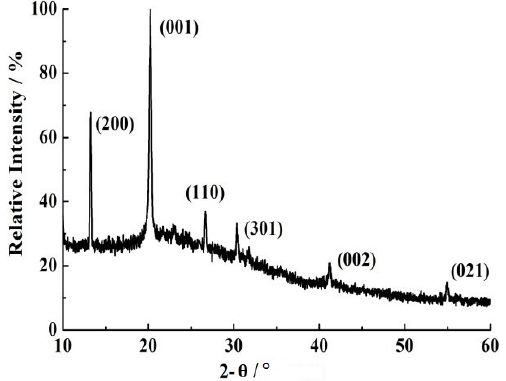
Figure 2. XRD pattern of as-grown vanadium oxide thin films by APCVD on fluorine-doped SnO 2 (FTO) glass substrates at 450 °C, using gas precursor ratio of 1:3.